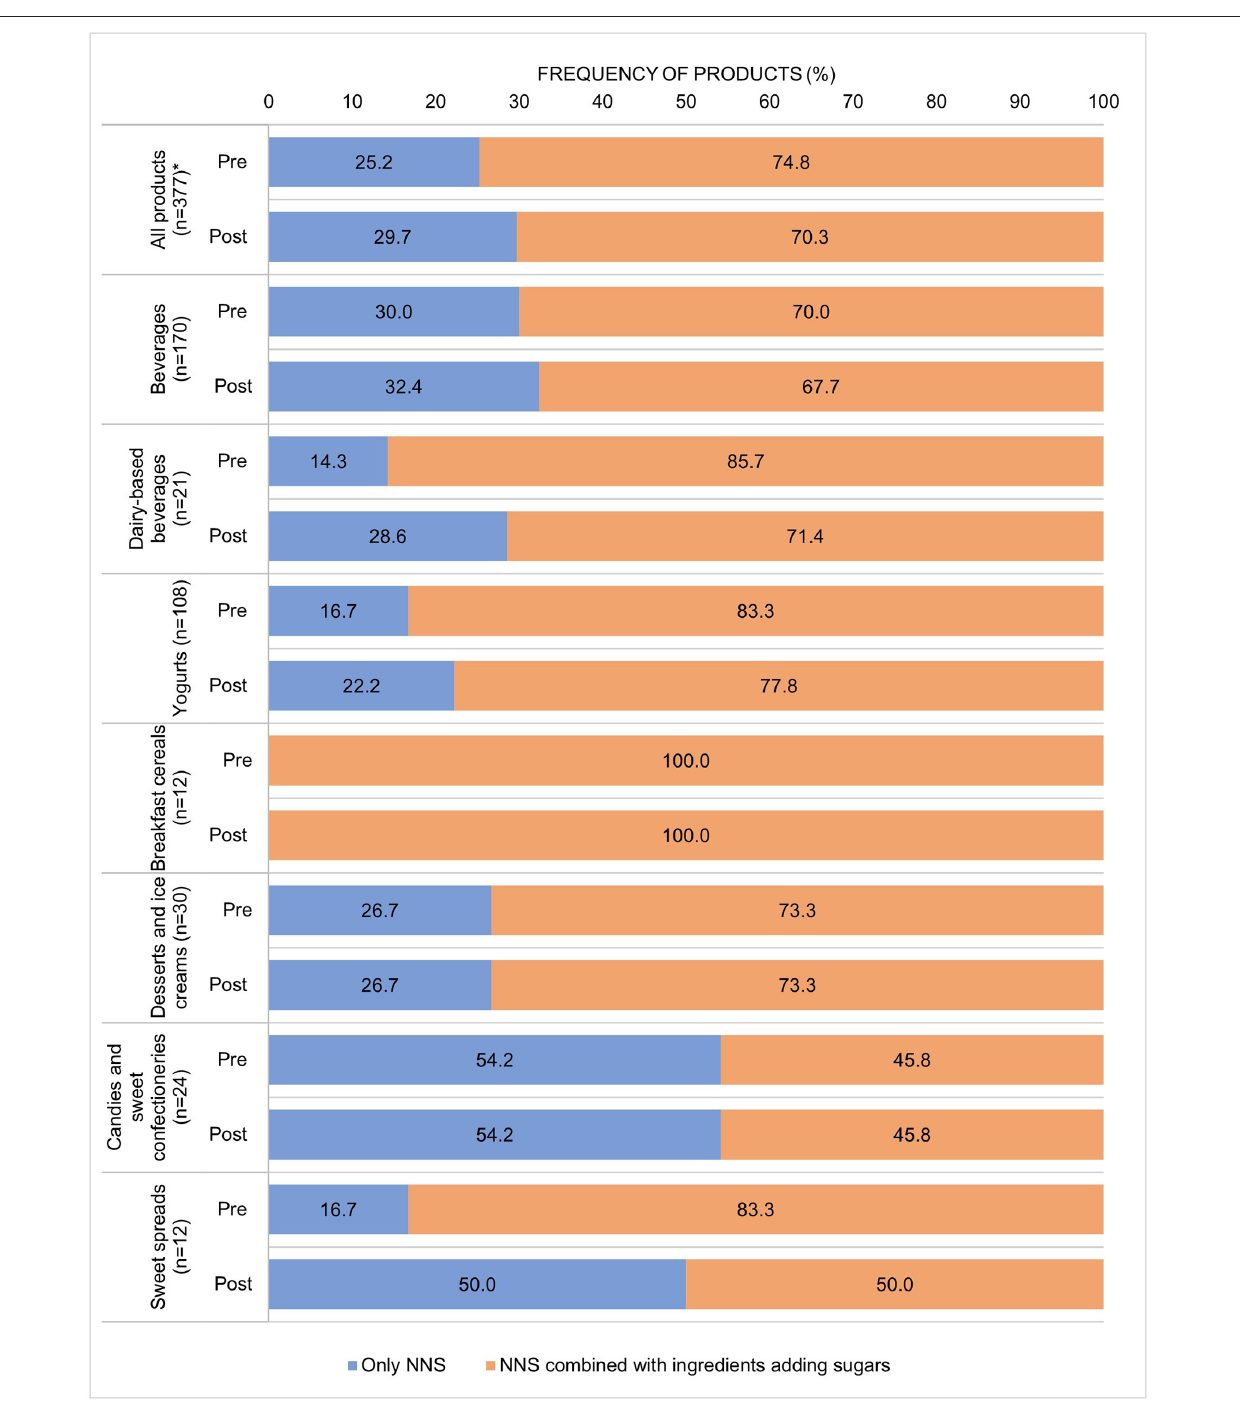
FIGURE 2 | Use of NNSs only or NNSs in combination with ingredients adding sugars in the pre- and post-implementation periods by food or beverage group. * p value < 0.001 in the McNemar test.